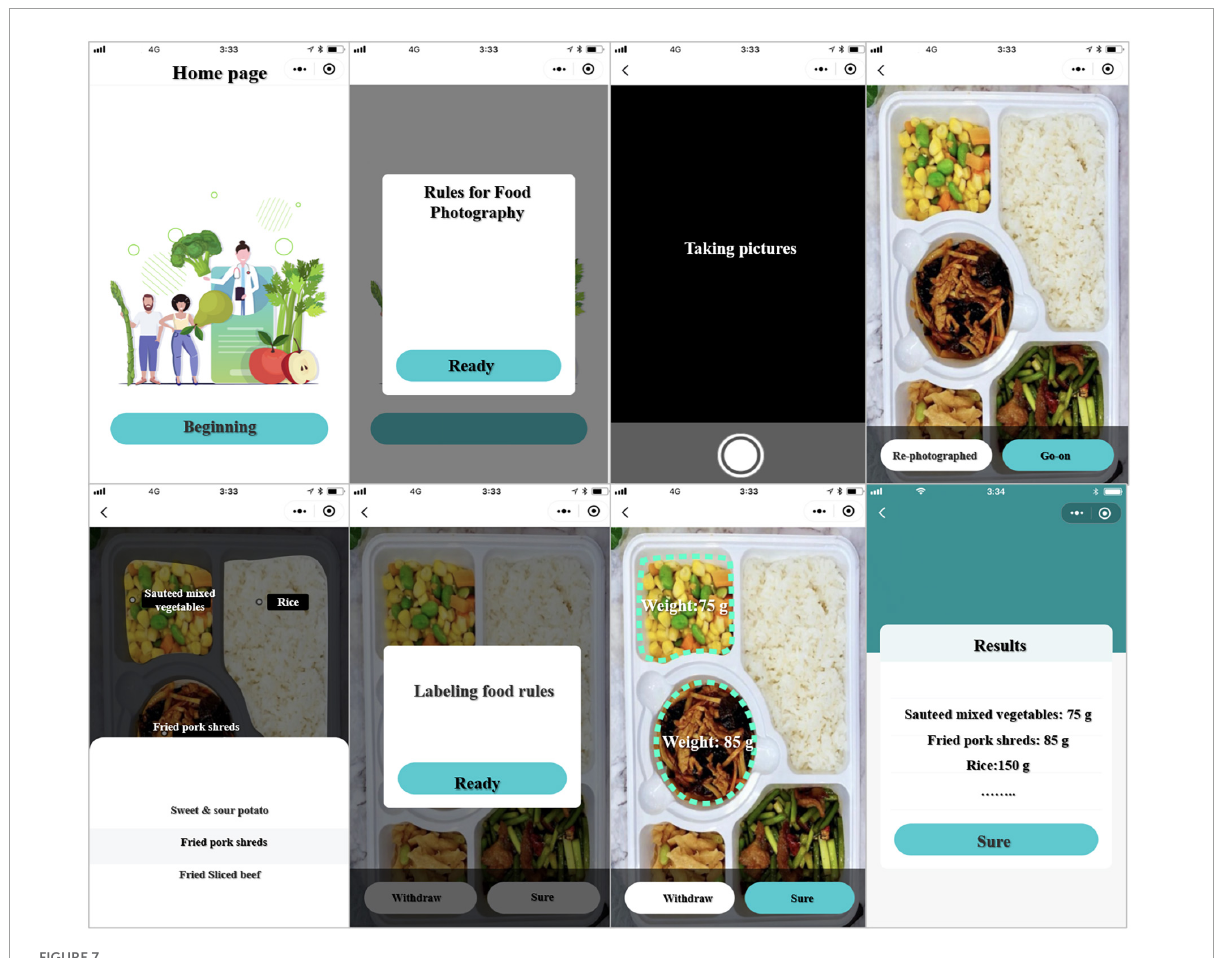
FIGURE7 Mobile terminal application page display diagram.